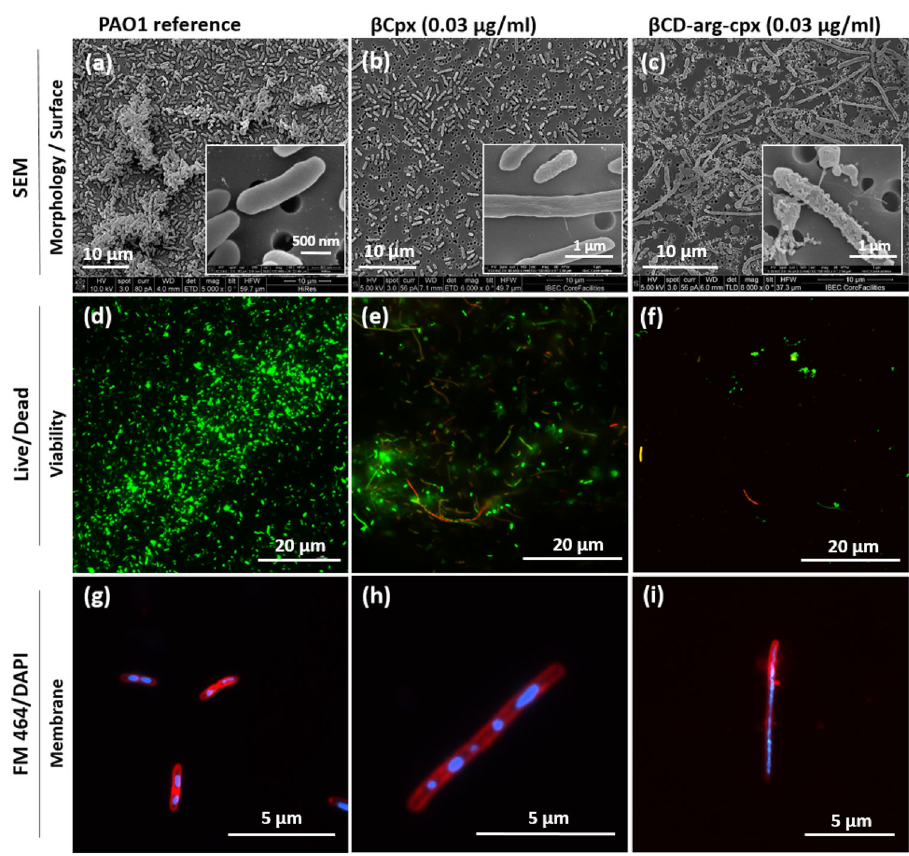
Fig. 8 P. aeruginosa PAO1 exposed to cipro fl oxacin and its β CD-arg complex. Morphology and surface of PAO1 cells before ( a ) and after exposure to low cpx concentration (0.03 μ g/ml or 0.08 μ M) ( b ) and equivalent cpx in β CD-arg-cpx (0.03 μ g/ml or 0.02 μ M) ( c ). Live P. aeruginosa PAO1 stained with a Live/Dead dyes ( d ) and fraction of viable cells treated with 0.03 μ g/ml cpx (0.08 μ M) ( e ) and β CD-arg-cpx (0.02 μ M) ( f ). Membrane structure of wild- type P. aeruginosa PAO1 stained with FM464/DAPI dyes ( g ) and bacteria treated with 0.03 μ g/ml pure cpx (0.08 μ M) ( h ) and β CD-arg-cpx complex (0.02 μ M) ( i ).